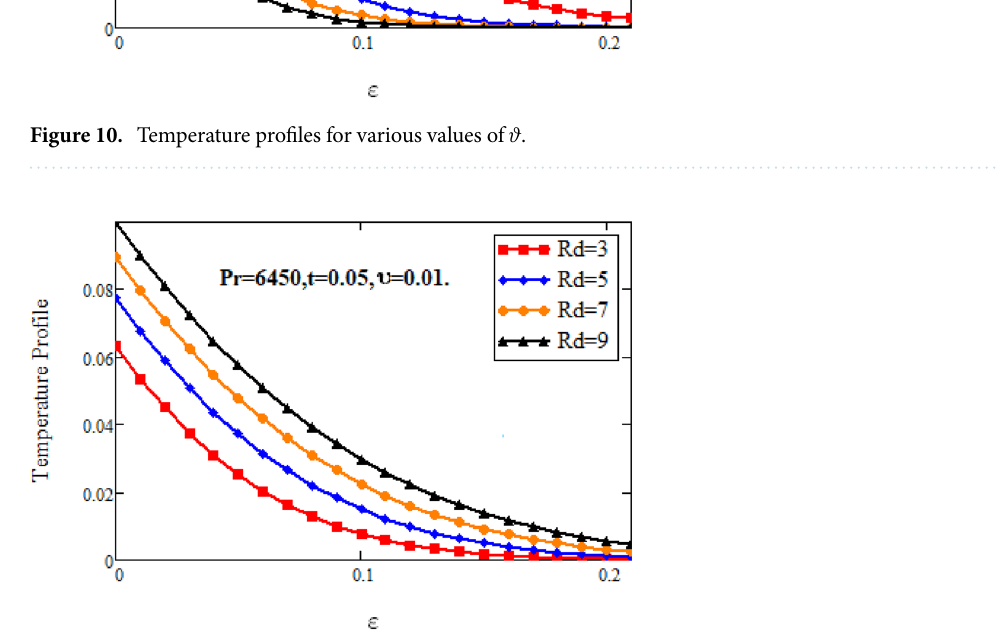
Figure 11. Temperature profiles for various values of